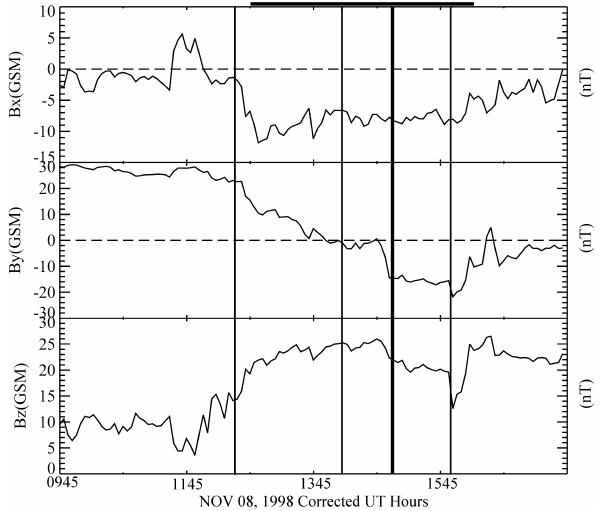
Fig. 8. Shown are magnetic field data from the ACE satellite which orbits the L1 Lagrangian point about 200 R E sunward of the Earth. IMF GSM components are plotted for 8 November 1998, as a func- tion of corrected universal time (UT plus the estimated propagation time from the satellite to GSM X =0); about 45min. The thick verti- cal line marks the time when Polar UVI shows a TPA aligned along the noon-midnight meridian in the Northern Hemisphere. The three thin vertical lines mark the time when DMSP F13 reaches highest latitudes over the Northern Hemisphere. The thick horizontal line at the top denotes the time period when UVI data are available.